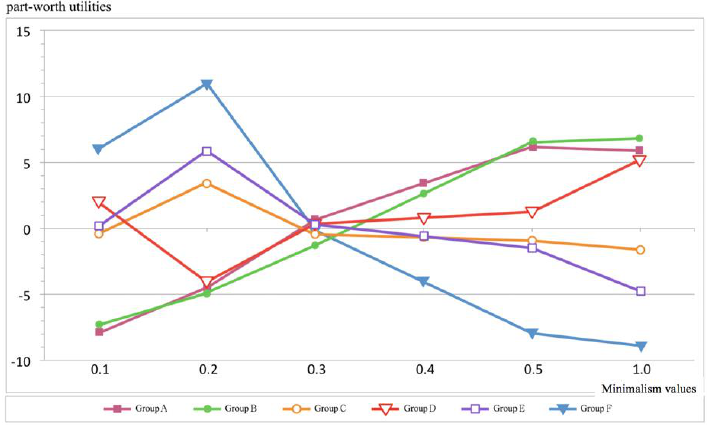
Figure 9. Part − worth utilities of different Minimalism values for the six groups.